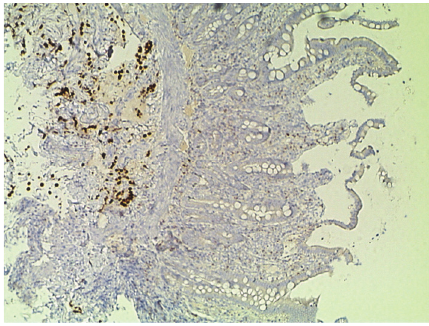
Figure 4: Duodenal biopsy showing strong nuclear GATA3 immunoreactivity in many tumor cells, which are observed more readily on immunostaining than on H&E histology ( ×